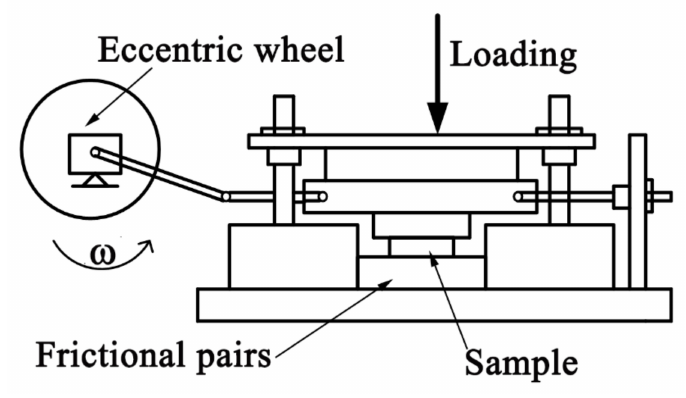
Figure 4. Schematic of the siding wear